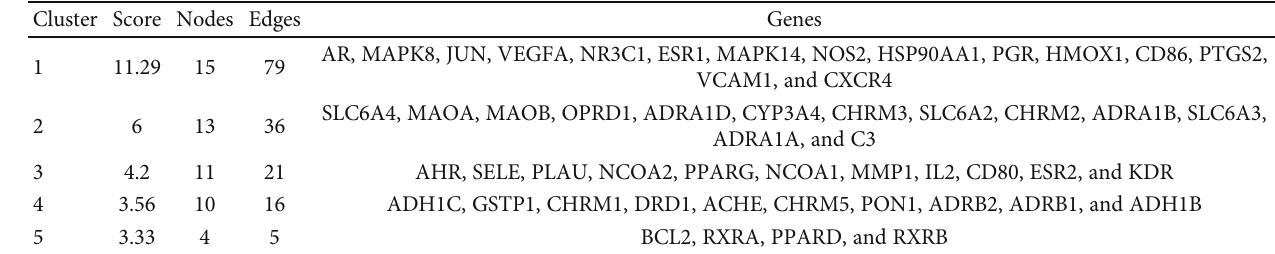
BCL2, RXRA, PPARD, and